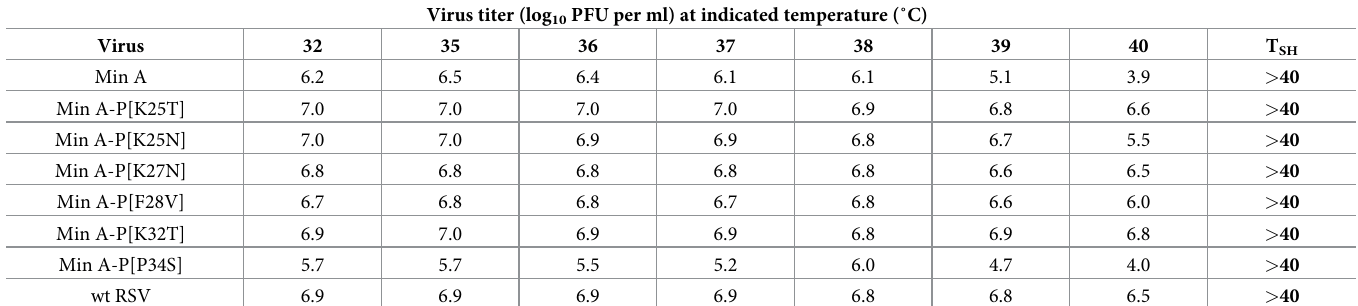
Table 2. Temperature sensitivity of the CPD RSVs on Vero cells. Virus titer (log 10 PFU per ml) at indicated temperature